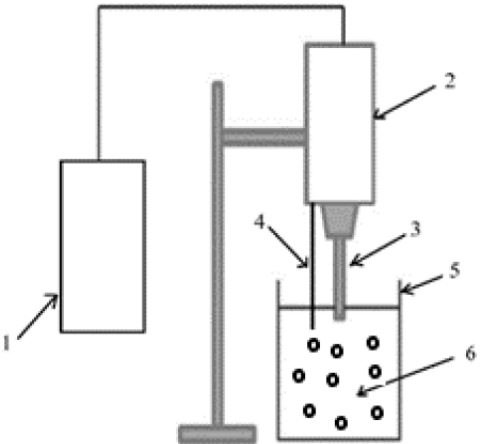
Figure 1: Schematic presentation of the ultrasonic apparatus for sonochemical synthesis. 1=ac generator, 2=ultrasonic converter, 3=sonotrode, 4=Pt100 thermometer, 5=beaker, 6=suspension.